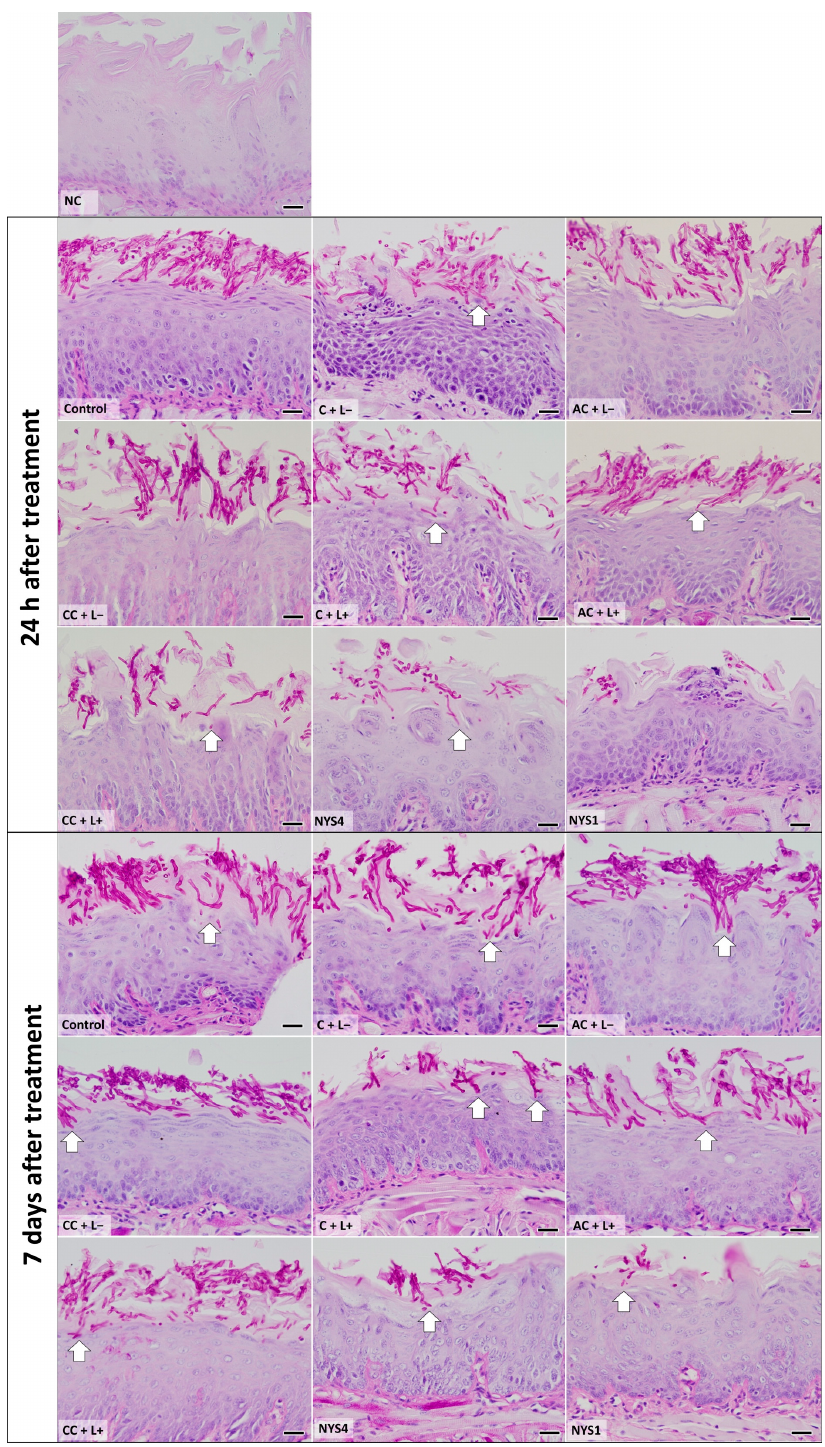
Figure 6. Light micrographs showing sections of tongue mucosa submitted to the periodic acid-Schiff (PAS) histochemical method. The light micrographs show the epithelium tongue of healthy, infected, and treated animals, euthanized 24 h and seven days after treatment. NC group: healthy and untreated animals; Control group: infected animals that did not receive any treatment (C − L − ); C + L+, AC